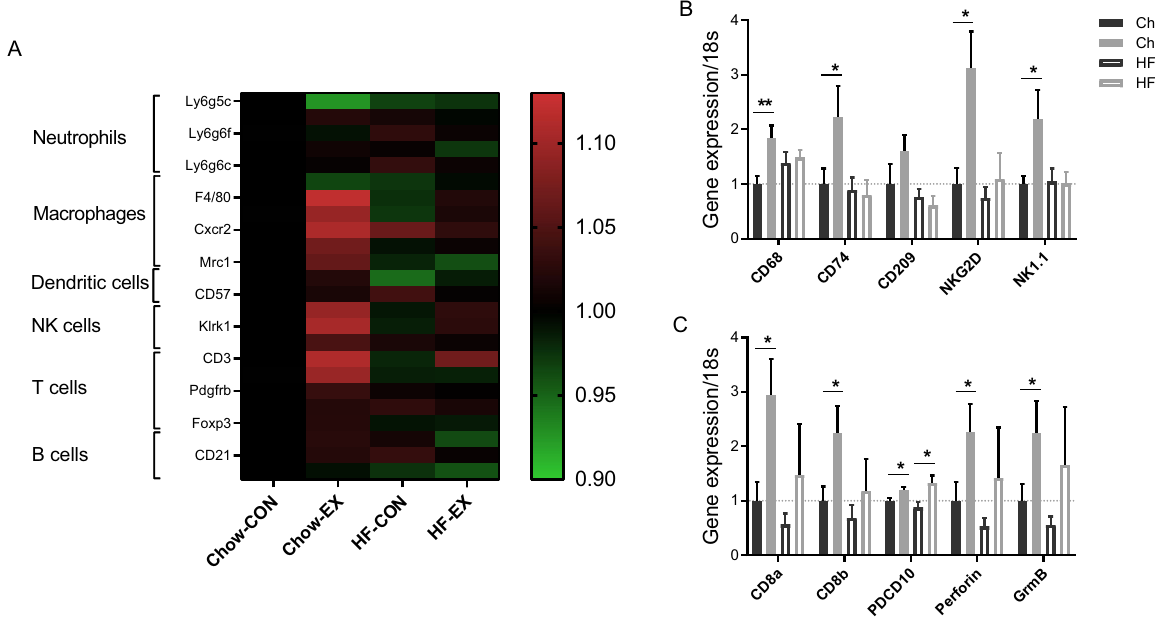
Figure 4. High-fat feeding suppresses exercise-mediated innate immune recognition. Expression of selected markers for different immune subsets by microarray analysis in C57bl/6 mice that were randomized to cages containing running wheels for 4 weeks prior to tumor inoculation and during tumor challenge (EX) or no running wheel (CON), and further randomized to chow or high-fat feeding (HF) (n = 5, study design 1) ( A ). Gene expression by PCR analysis of ( B ) markers of myeloid cells/macrophages and NK cells, and ( C ) markers and cytolytic enzymes of T cells (n = 9–12). Statistical significance was determined by 2-way ANOVA with Tukey’s post hoc test for each gene. Individual stars indicate difference from the control group. * p < 0.05, ** p <